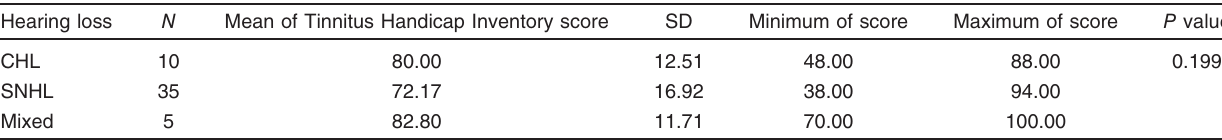
Table 2 Impact of hearing loss type on Tinnitus Handicap Inventory score Hearing